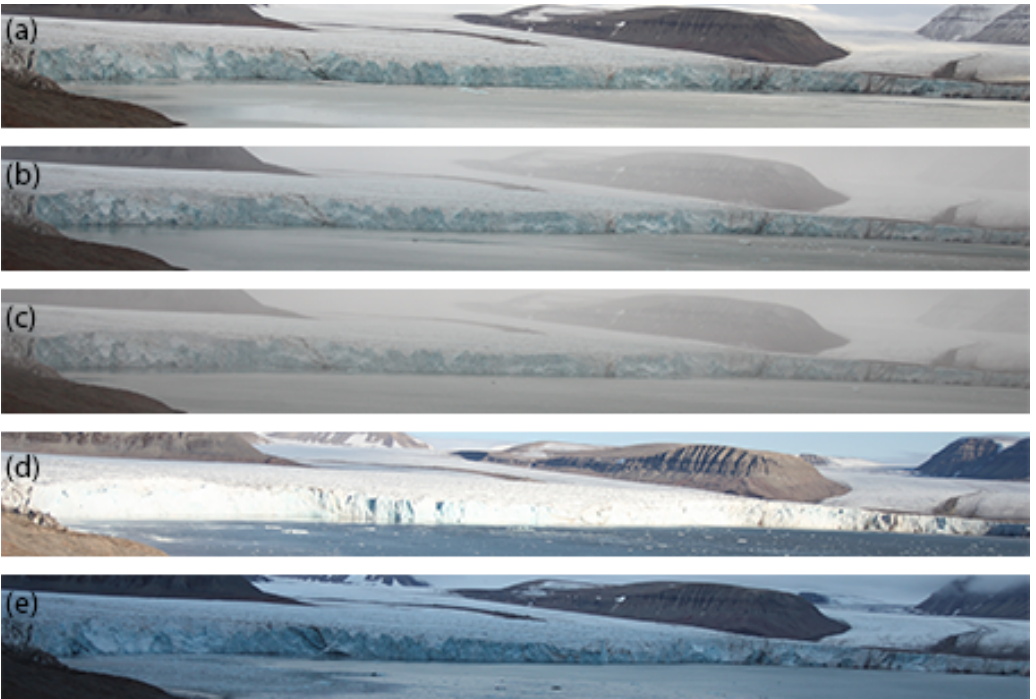
Figure 5. Weather conditions and illumination categories: (a) normal (N), (b) light fog (LF), (c) dense fog, (d) high illumination and (e) low